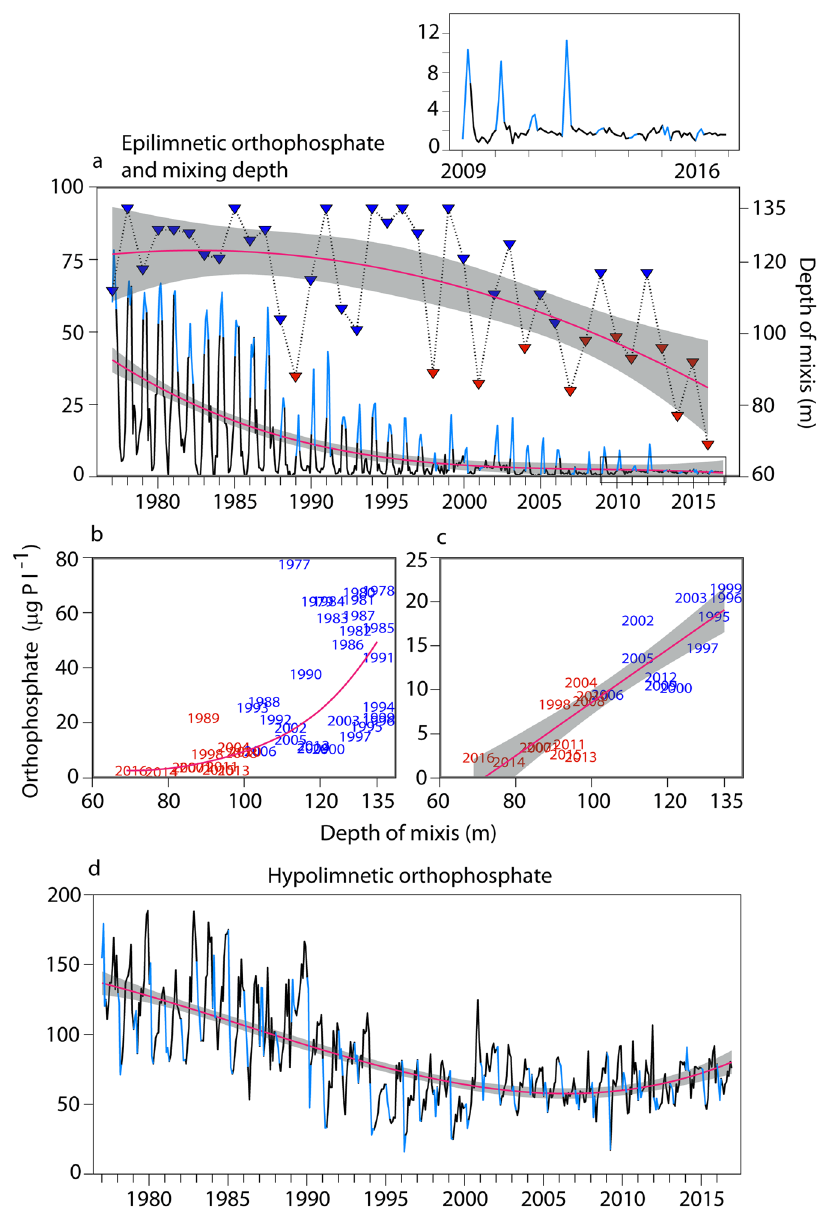
Figure 2. Long-term trends (1977 to 2016) of mixing depth and orthophosphate concentrations. ( a ) Dotted line and triangles: mean water turnover depth ( n = 40) with color code for years with mixing depth < 100 m (red) and ≥ 100 m (blue), and regression line ( f = y 0 + a * x + b * x 2 , r 2 = 0.4 2 , p = 0.08 ). Solid line: epilimnetic orthophosphate concentrations ( n = 480) with highlighted periods of water turnover (January to April, light blue) and regression line ( f = y 0 + a * x + b * x 2 + c * x 3 , r 2 = 0.43, p < 0.05 ). The period 2009 to 2016 is enlarged to show that epilimnetic phosphorus enrichment stopped since the year 2013. ( b ) Relationship between mean mixing depth and epilimnetic orthophosphate for the years 1977 to 2016 ( f = y 0 * e b * x , r 2 = 0.60 , p < 0.001 ), and ( c ) 1995 to 2016 ( f = b * x + a , r 2 = 0.79 , p < 0.001 ) with colors as in ( a ). ( d ) Hypolimnetic orthophosphate concentrations (solid line, n = 480) with highlighted periods of water turnover (January to April, light blue) and regression line ( f = y 0 + a * x + b * x 2 + c * x 3 , r 2 = 0.53, p = < 0.01 ). Grey shaded areas in ( a,c,d ) show confidence